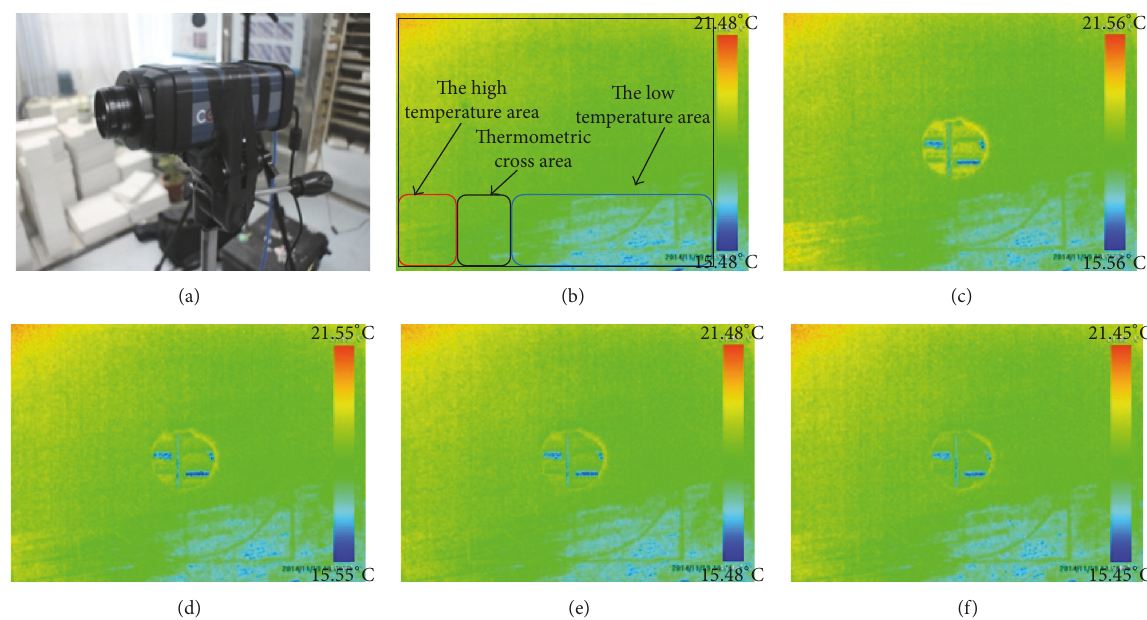
Figure 6: Picture of infrared imager and infrared images; (a) picture of infrared thermal imager; (b) infrared image taken after the first loading; (c)–(f) the infrared images taken around the time point of Figures 3(a)–3(d),